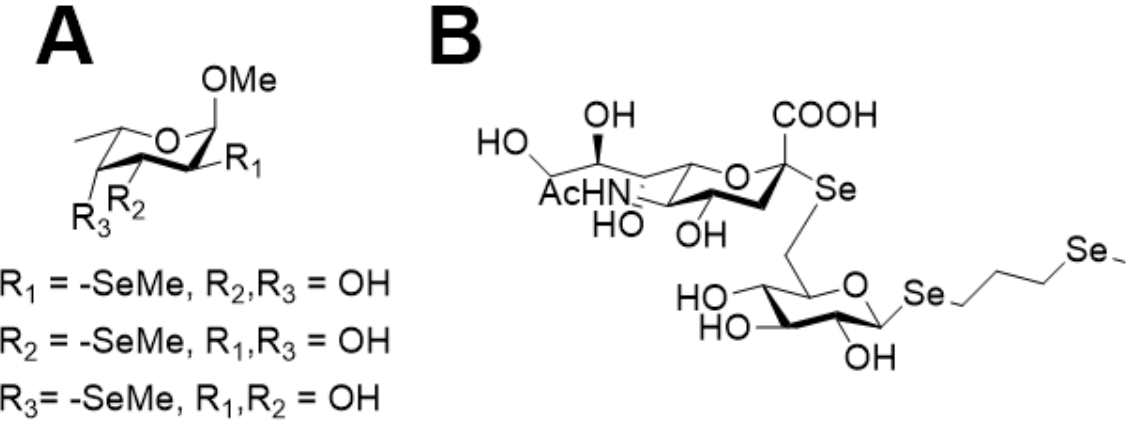
Figure 5. Crystal structures of transmembrane proteins Leukotriene C4 synthase (PDB ID: 3B29) ( A ) and pLGIC pentamer (PDB ID: 4IL4) ( B ) using SeDDM as the phasing detergent. The hydrocarbon chains of Se-DDM are shown in sky-blue.